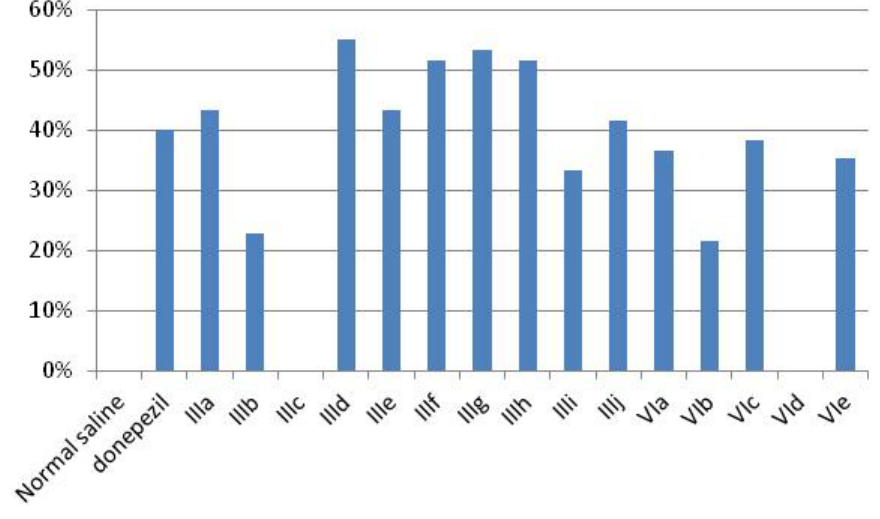
Figure 3. Bar chart representation of acetylcholinesterase percentage inhibition of normal saline, donepezil and the newly synthesized